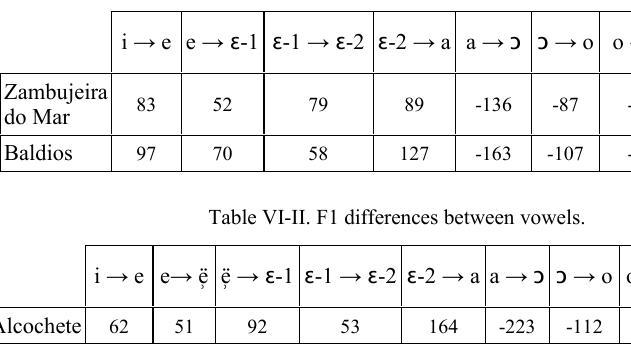
Table VI-I. F1 differences between vowels.